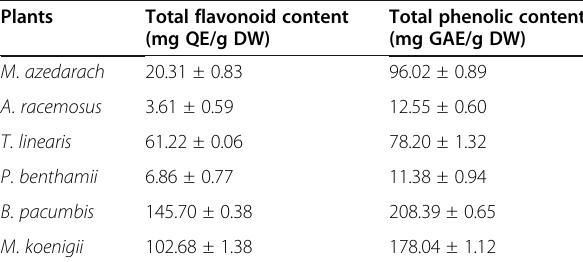
Table 3 Results on total flavonoid content and total phenolic content